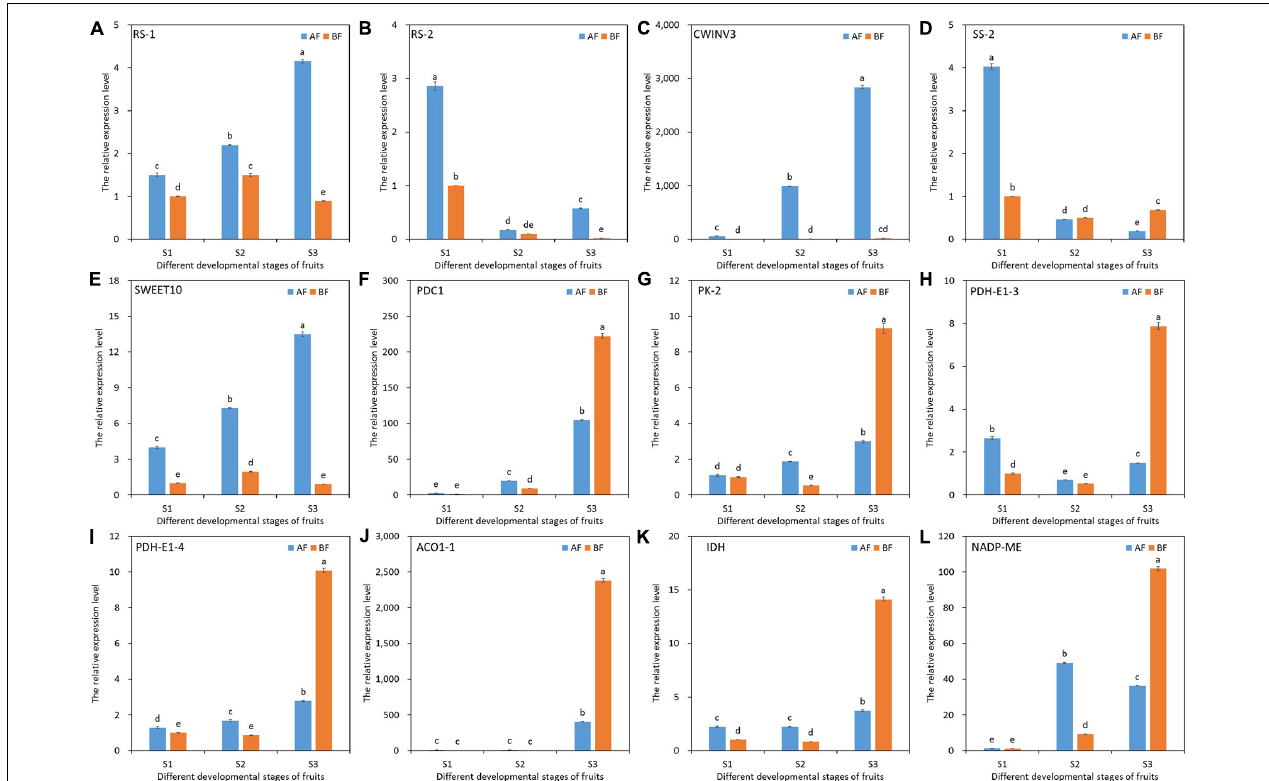
FIGURE 7 | qRT-PCR validation of 12 selected DEGs related to soluble sugar and organic acid metabolism. The enzymes names are labeled on the upper left of the separated figures. GAPDH (CuGenDB number: MELO3C008219) was used as the reference gene. The data of BFS1 were used as the control to calculate the relative expression levels. (A) RS-1. (B) RS-2. (C) CWINV3. (D) SS-2. (E) SWEET10. (F) PDC1. (G) PK-2. (H) PDH-E1-3. (I) PDH-E1-4. (J) ACO1-1. (K) IDH. (L)